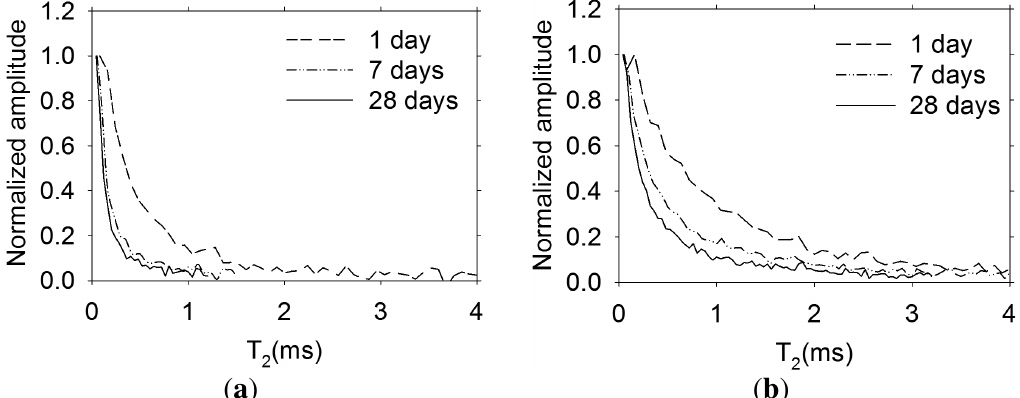
Figure 9. Normalized t ransverse magnetization decay measured with the embedded sensors in concrete ( a ) w/c ratio = 0.30